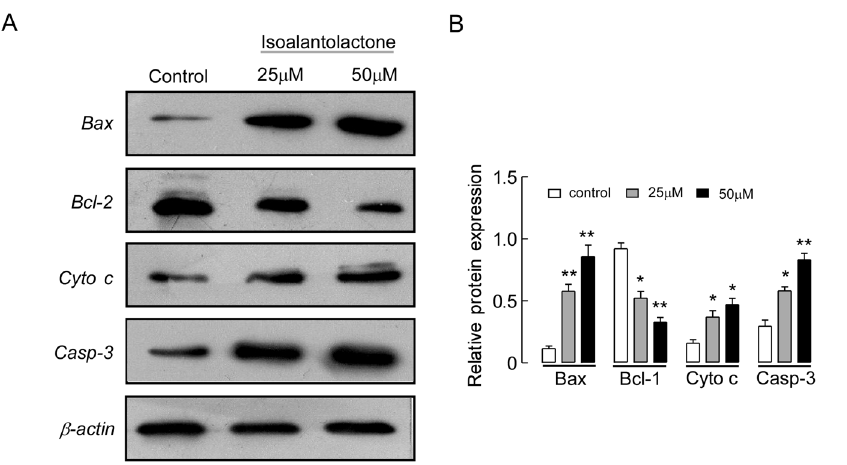
Figure 6. The effect of isoalantolactone on the expression of caspase-dependent mitochondrial apoptosis pathway proteins in UM- SCC-10A cells. (A) Representative images of cytochrome c, Bax, Bcl-2 and caspase 3 protein expression detected by western blot. b -actin was used as a control. (B) The data are represented as the means 6 SEM from three independent experiments with similar results. * P , 0.05 and ** P , 0.01 compared to the